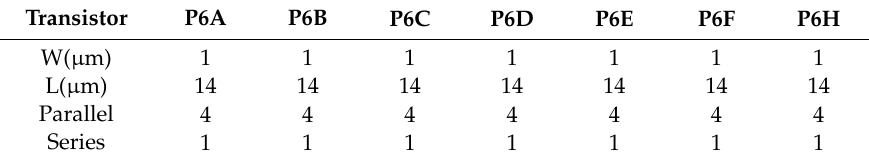
Table 4. Transistor dimensions of the trimming circuit.